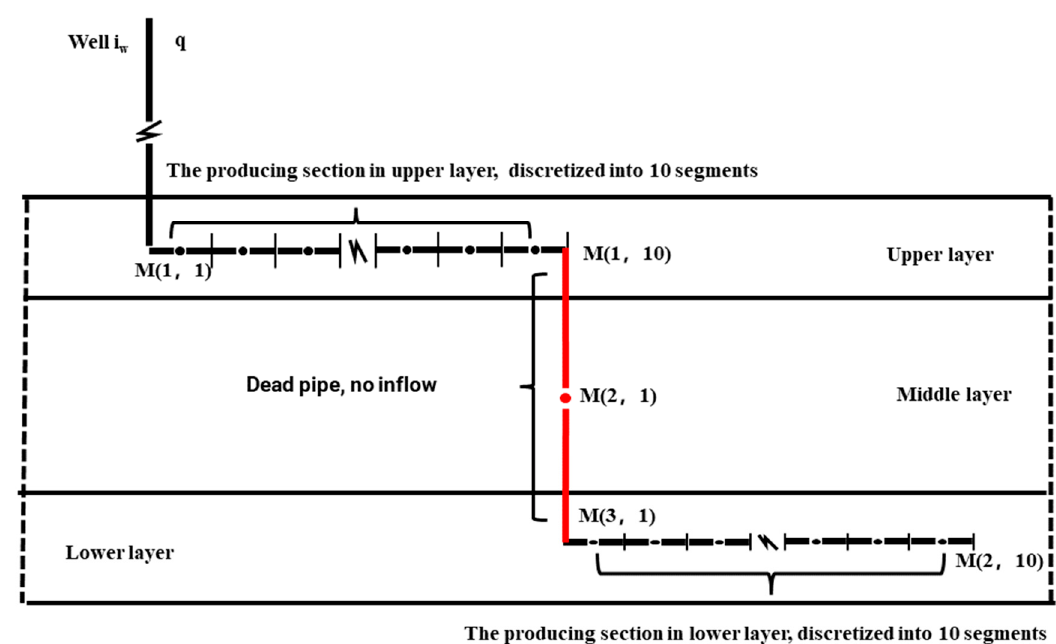
Figure 15. Schematic diagram of simplified reservoir and stepped well in the case.